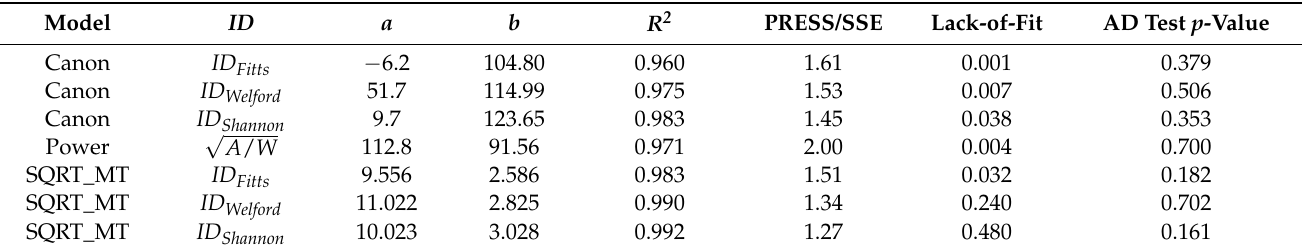
Table 2. Performances of 1 lb stylus tapping task with the Canon, Power, and SQRT_MT models using Fitts’ data [1]. The results were consistent with the 1 oz stylus tapping